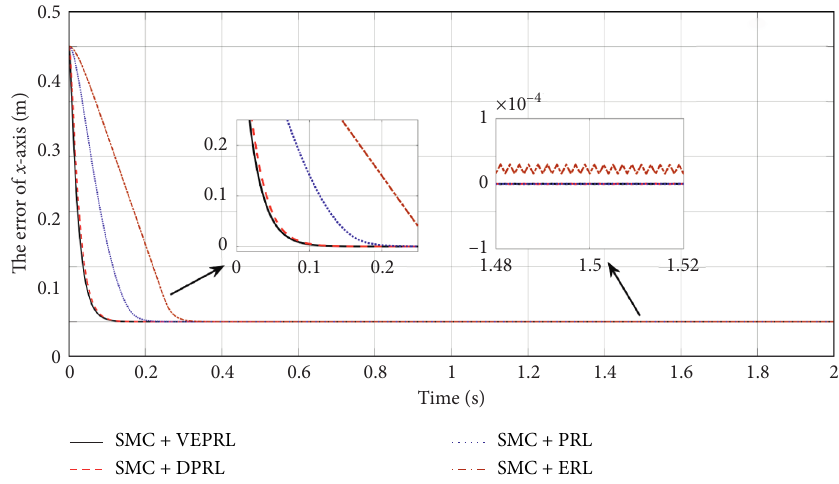
Figure 3: Comparison of x -axis tracking error of theball and plate system under SMC.